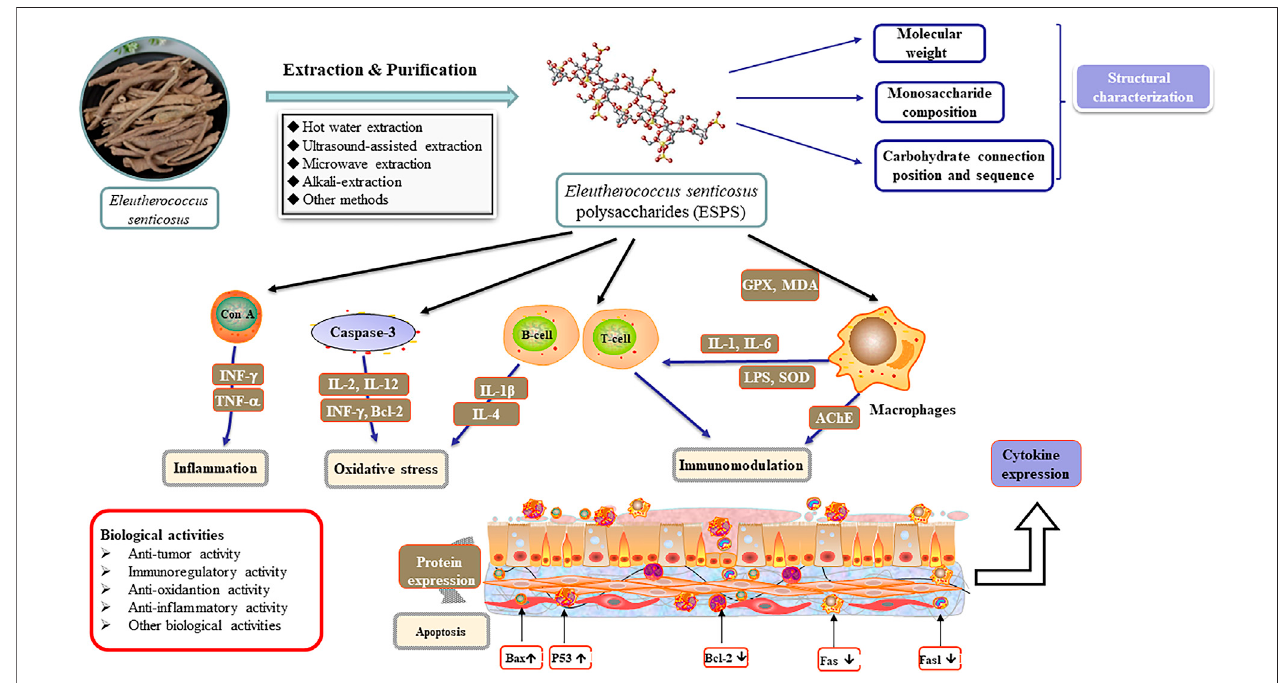
FIGURE 3 | Schematic diagram of biological activity mechanism of